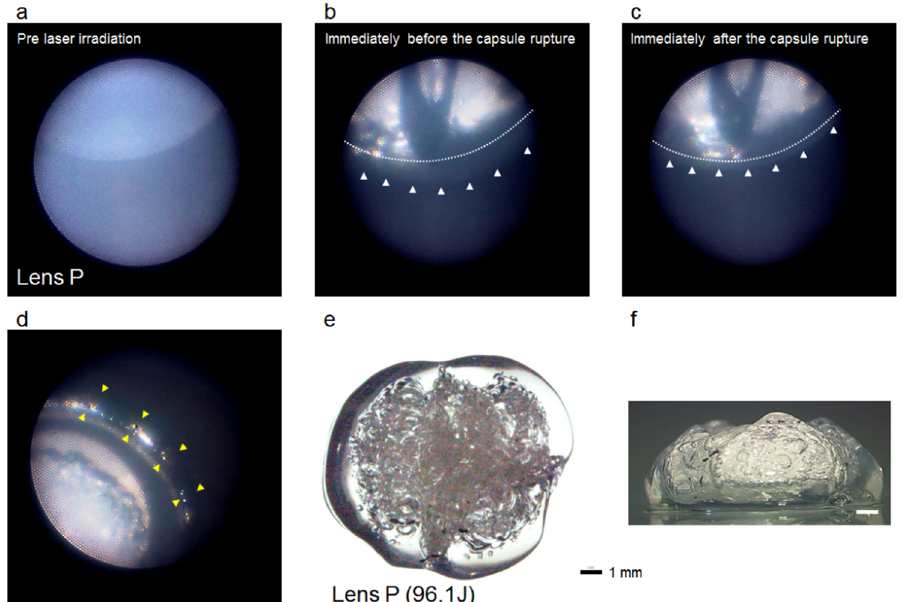
Figure 4. The greater the laser irradiation energy was, the more gas was produced. If pressure exceeded maximal pressure levels of the capsule, it ruptured. ( a – c ) Endoscopic images of lens P during laser irradiation procedure. ( a ) Before laser irradiation. (b) Immediately before rupture by CBS during laser irradiation. ( c ) Immediately after rupture by CBS during laser irradiation. ( d ) Endoscopic images of lens P from the posterior pole of the eye after laser irradiation. White dotted line indicates capsule position before laser irradiation; white arrowheads indicate posterior position after expansion; yellow arrowheads indicate gas distribution after bursting into the vitreous cavity behind the ciliary body. ( e , f ) Microscopic image of extracted lens P. Error bar is 1 mm. Laser irradiation energy amount listed in parentheses.